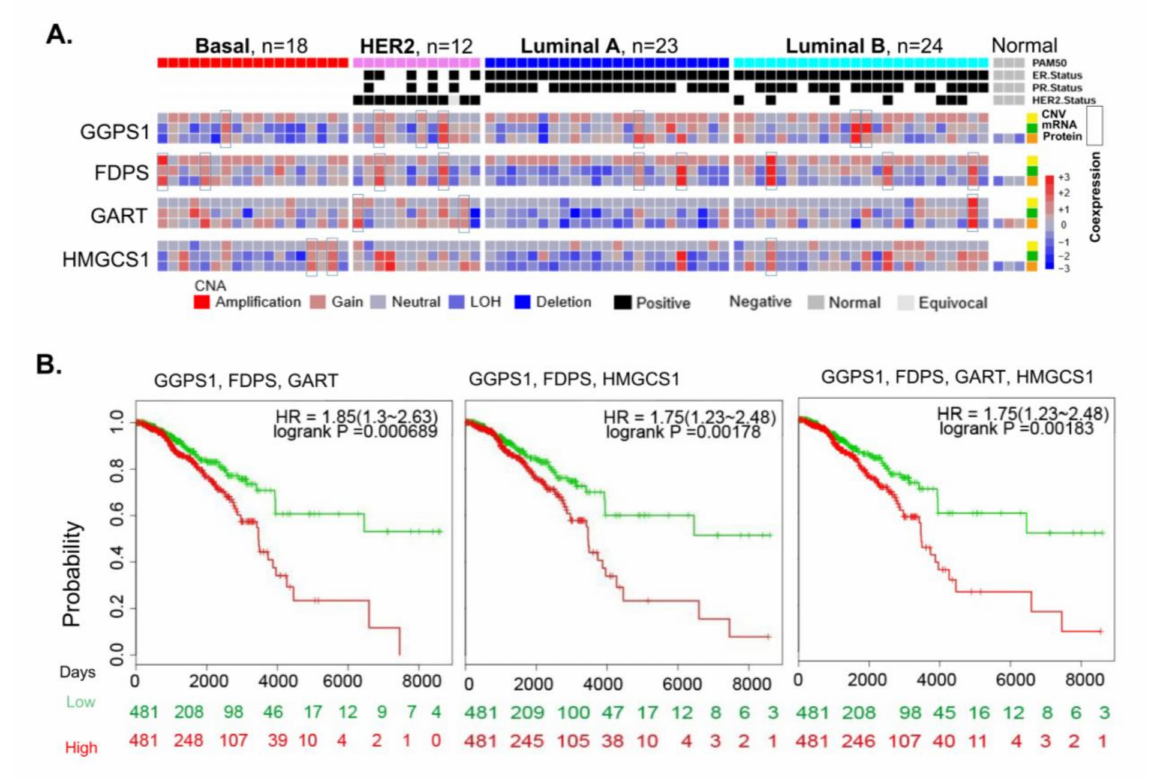
Figure 5. Coexpression and significance of GGPS1, FDPS, GART and HMGCS1 in breast cancer. ( A ) Proteogenomics expression status of the four indicated molecules in breast tumors. Yellow: CNV, Green:a RNAseq, and Orange: Protein [48]. ( B ) SurvExpress [32] survival analysis of GGPS1, FDPS, and GART and that of GGPS1, FDPS, GART, and HMGCS1 in patients with breast